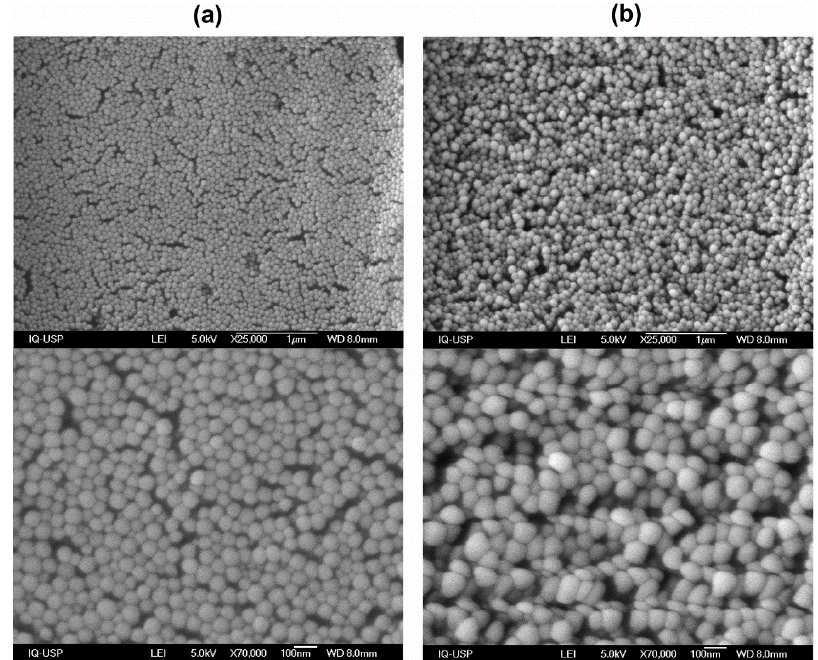
Figure 1. Scanning electron micrographs (SEM) of original dispersions of poly methyl methacrylate / dioctadecyldimethylammonium (PMMA / DODAB) ( a ) or PMMA / CTAB nanoparticles (NPs) on silicon wafers ( b ). The magnification was either 25,000 × (on the top) or 70,000 × (on the bottom). The mean diameter of dry NPs (D) was compared to the one of NPs in water dispersion given by dynamic light scattering (DLS) as the mean hydrodynamic diameter (Dz) (Table 1).